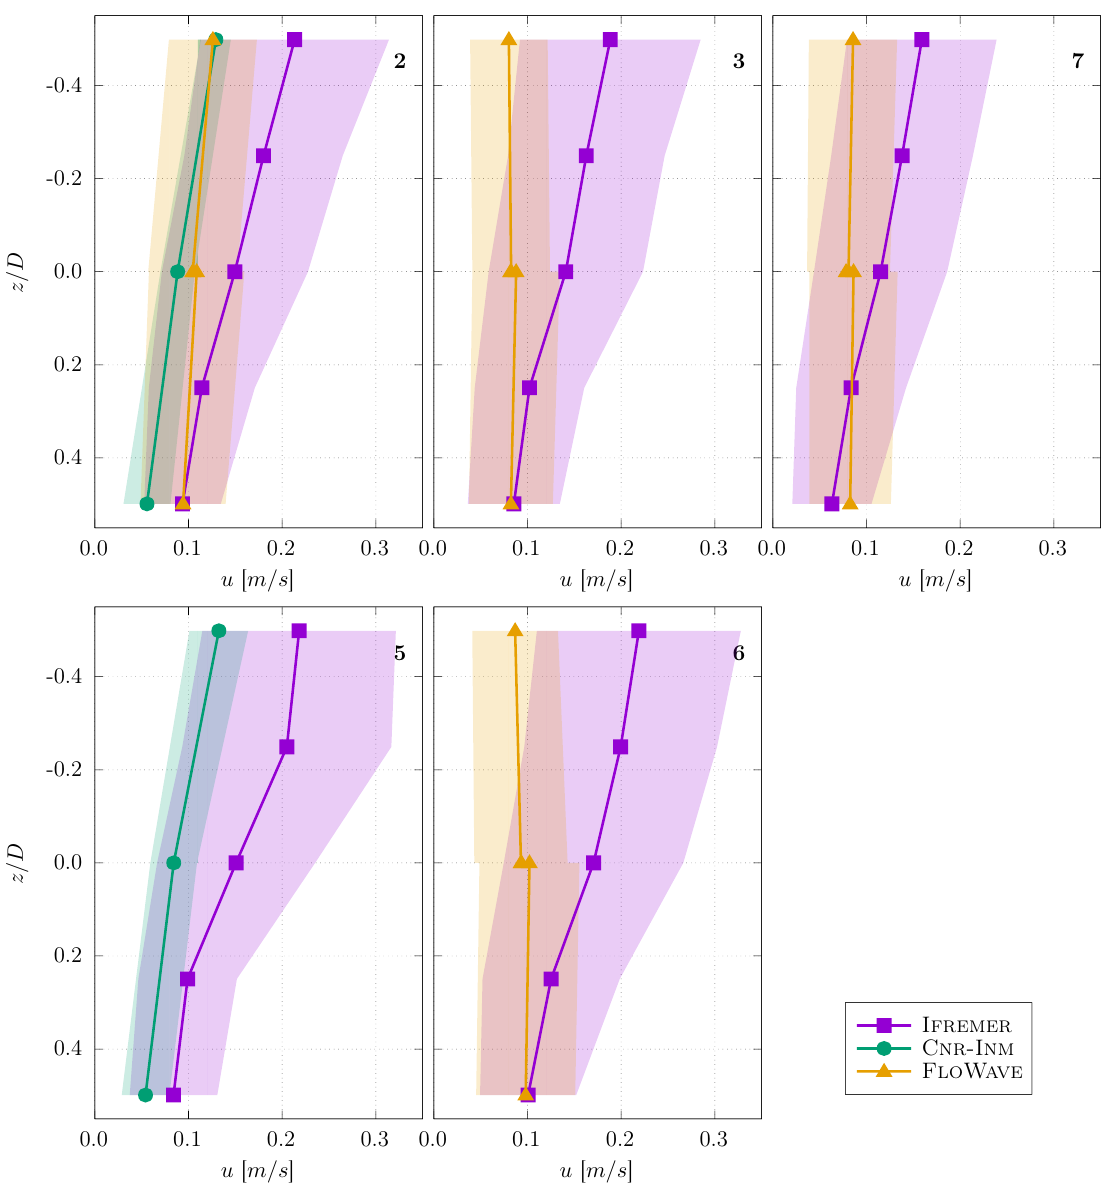
Figure 12. Vertical profiles of the average and standard-deviation of the amplitude of the Hilbert transform of the stream-wise component of the velocity at the turbine location. Numbers 2 to 7 stand for the different generated test cases (see Table